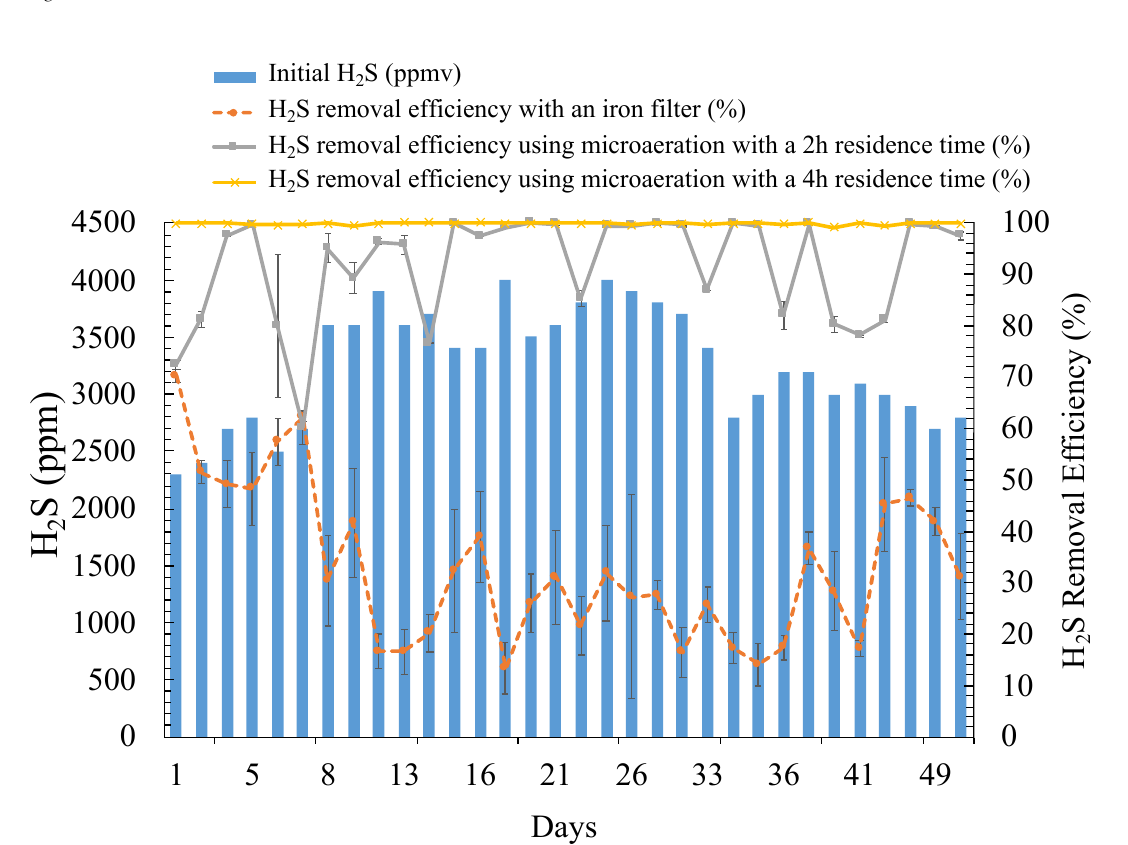
Figure 2. Relationship between initial H 2 S (ppm) and H 2 S removal efficiency (%) using iron filter and microaeration treatments, with gas analysis at 2 h and 4 h after initial air injection for microaeration.